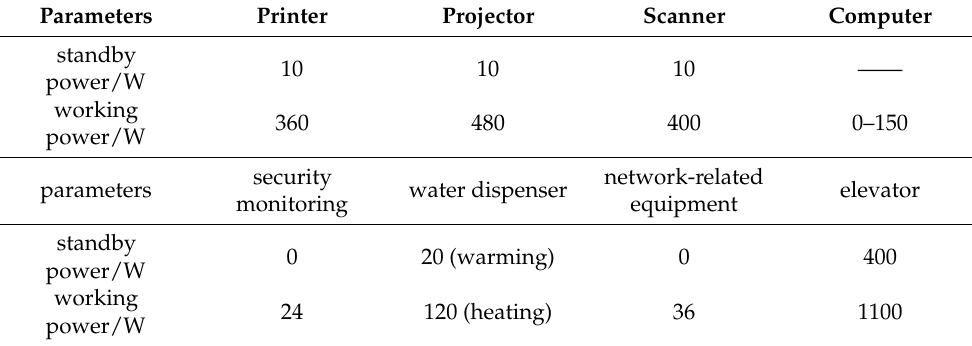
Table 2. Appliance parameters in the office